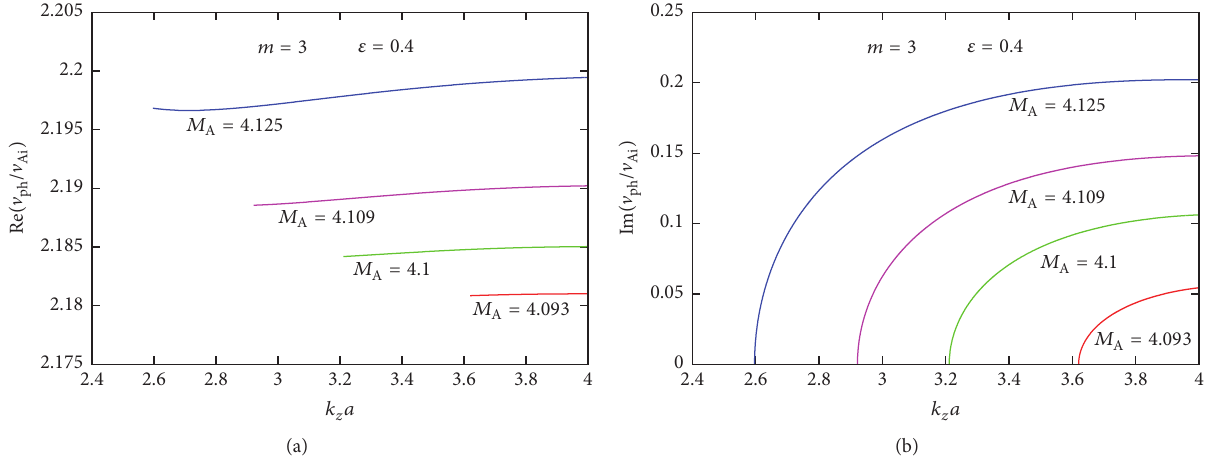
Figure 11: (a) Dispersion curves of unstable ( 𝑚 = 3 ) MHD mode propagating in a moving twisted flux tube of incompressible plasma (modeling jet #11) at the same parameters as in Figure 8 and for 𝑀 A = 4.093 , 4.1, 4.109, and 4.125. (b) The normalized growth rates for the same values of 𝑀 A